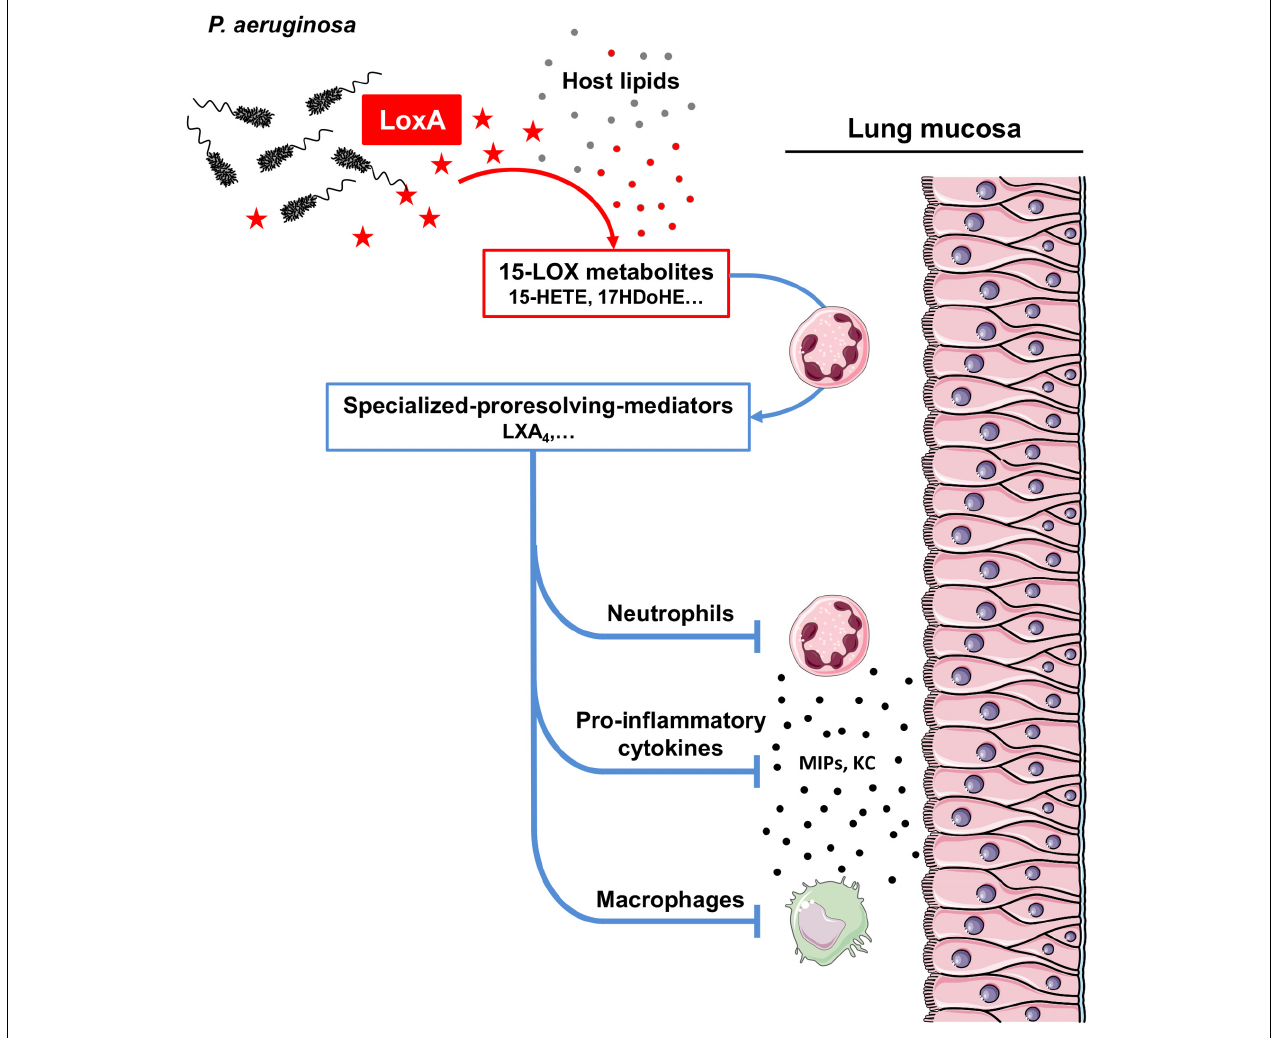
FIGURE 6 | Scheme model of how LoxA contributes to P. aeruginosa pathogenesis. P. aeruginosa can naturally secrete a functional lipoxygenase LoxA (symbolized as red stars). This enzyme can process a wide range of PUFAs (shown as filled gray circles) present in the host lung mucosa, to further generate specific 15-LOX by-products (including 15-HETE, 17-HDoHE, etc; shown as filled red circles). Those metabolites can be further processed by recruited leukocytes, such as neutrophils, through a transcellular mechanism to subsequently produce specialized pro-resolving mediators (including LXA 4 ). The overproduction of such highly potent lipid mediators may then downregulates the secretion of specific immune mediators (e.g., MIPs and KC) as well as the function of cells critical for the antimicrobial defense (e.g., neutrophils and macrophages). As a result, LoxA may confer a survival advantage as this enzyme reduces P. aeruginosa clearance in lung